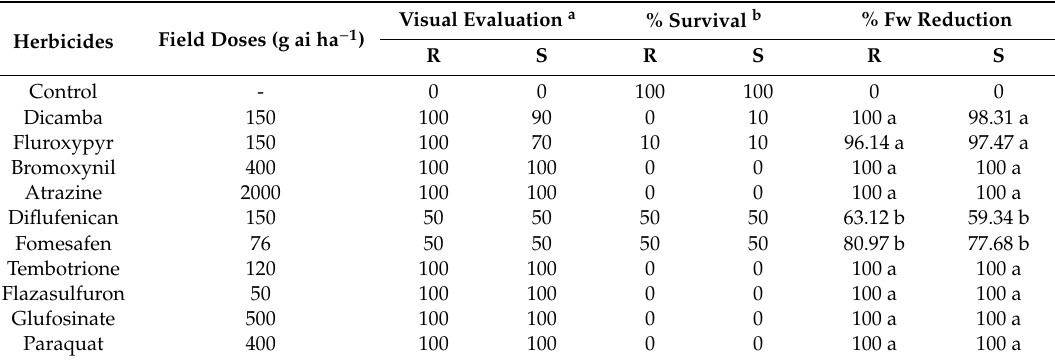
Table 5. Percentage of visual evaluation, % survival and % fresh weight (Fw) reduction compared to the untreated controls in resistant (R) and susceptible (S) populations of C. acanthoides with alternative control